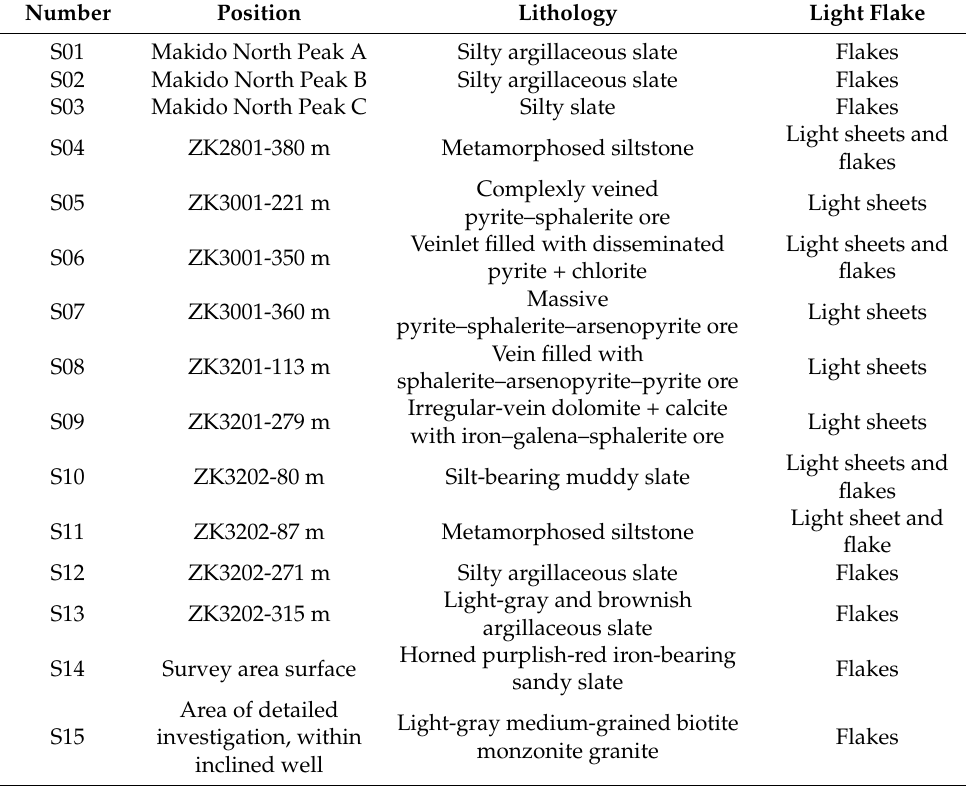
Table 3. Information about the samples analyzed in this